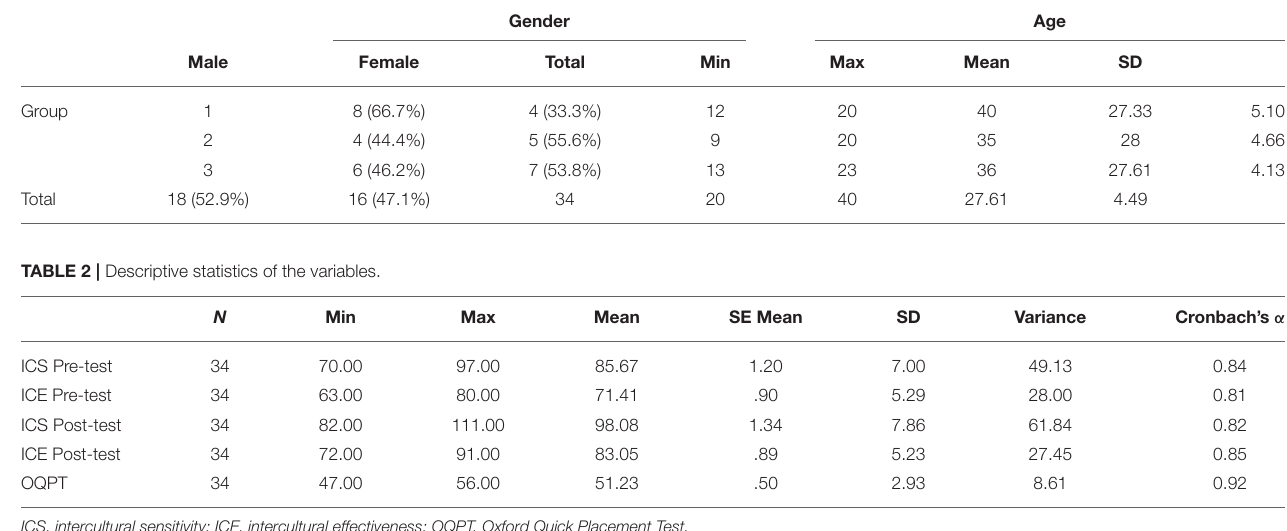
TABLE 1 | The descriptive statistics of the participants by group, gender, and age.